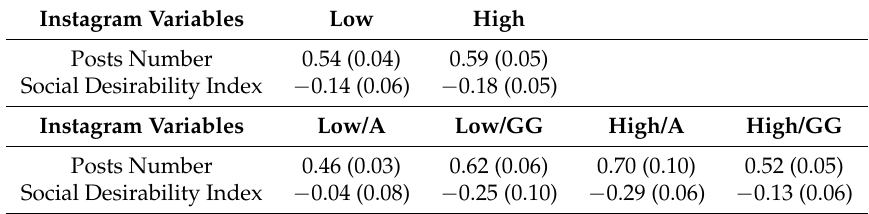
Table 5. Top section: mean values of variables with main effects. Line 1: mean values in low and high paternal care on the number of posts. Line 2: mean values in low and high maternal overprotection on the Social Desirability Index. Bottom section: mean values of significant interactions. Line 1: mean values in A-carriers and G/G homozygotes divided into low and high paternal care on the number of posts. Line 2: mean values in A-carriers and G/G homozygotes divided into low and high maternal overprotection on the Social Desirability Index. Standard Error Means (SEM) are reported between parentheses. Instagram Variables Low High Posts Number 0.54 (0.04) 0.59